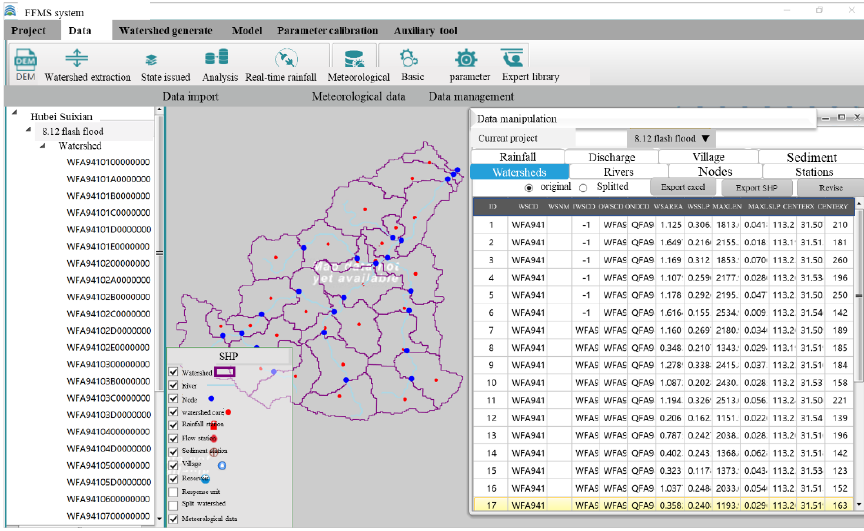
Figure 6. FFMS modeling process.